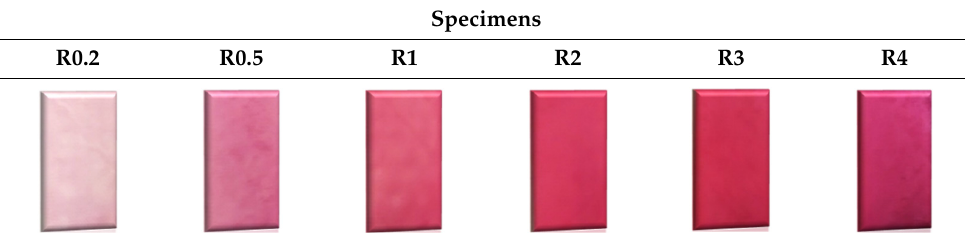
Figure 5. Spectral curves of red hue specimens (legend according Tables 6 and 7).